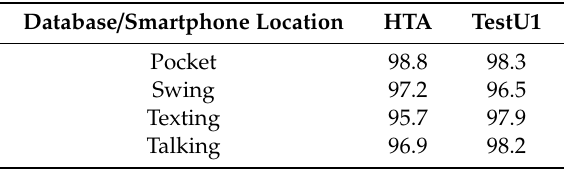
Table 5. Test accuracy results when training on the TrainU1 dataset with the CNN architecture while using both accelerometer and gyroscope measurements.